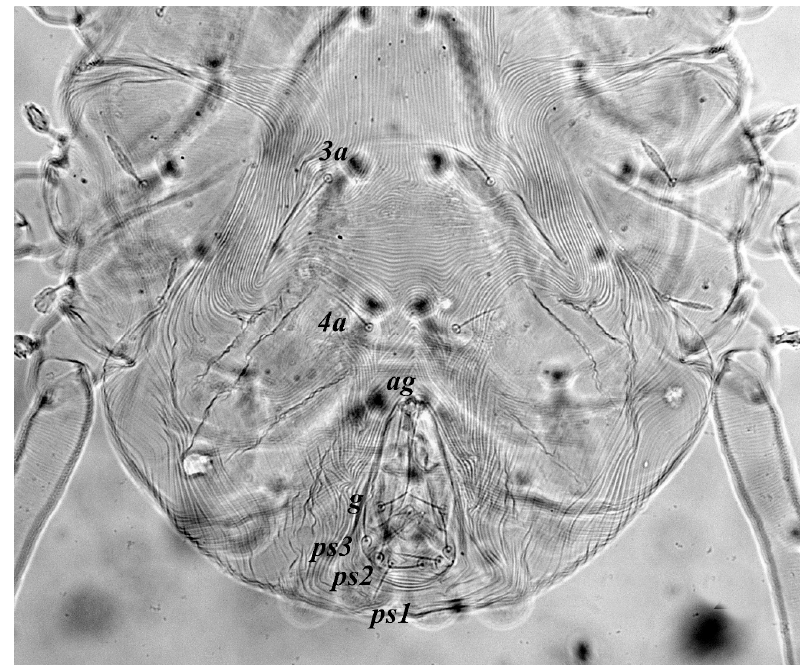
Figure 27. Decaphyllobius gersoni . Female. Venter.